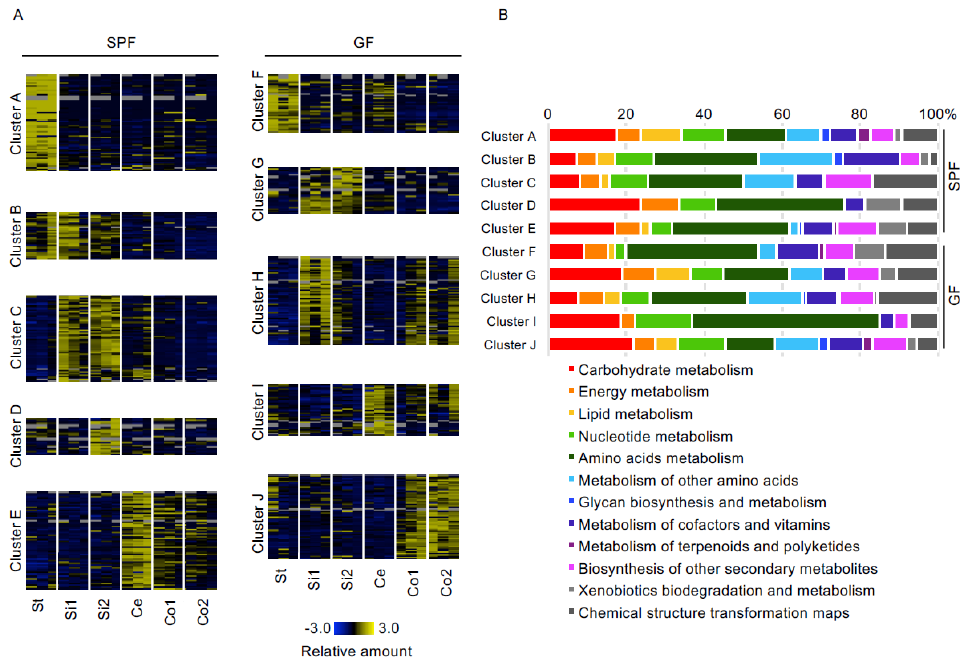
Figure 2. Differences in gastrointestinal luminal metabolites among different parts of the gastrointestinal tract of SPF and GF mice. ( A ) Heatmap of luminal metabolites categorized into five groups by using K-means analysis. Columns and rows correspond to gastrointestinal parts and metabolites detected by CE-TOFMS and LC-MS/MS, respectively. These profiles were normalized to a relative value between − 3 and 3. The colors indicate the z-score values calculated for the SPF and GF mice separately ( n = 3). St: Stomach, Si1: Upper small intestine, Si2: Lower small intestine, Ce: Cecum, Co1: Upper colon, Co2: Lower colon. ( B ) Bar graphs showing the composition of the KEGG categories based on the luminal metabolites in each cluster.